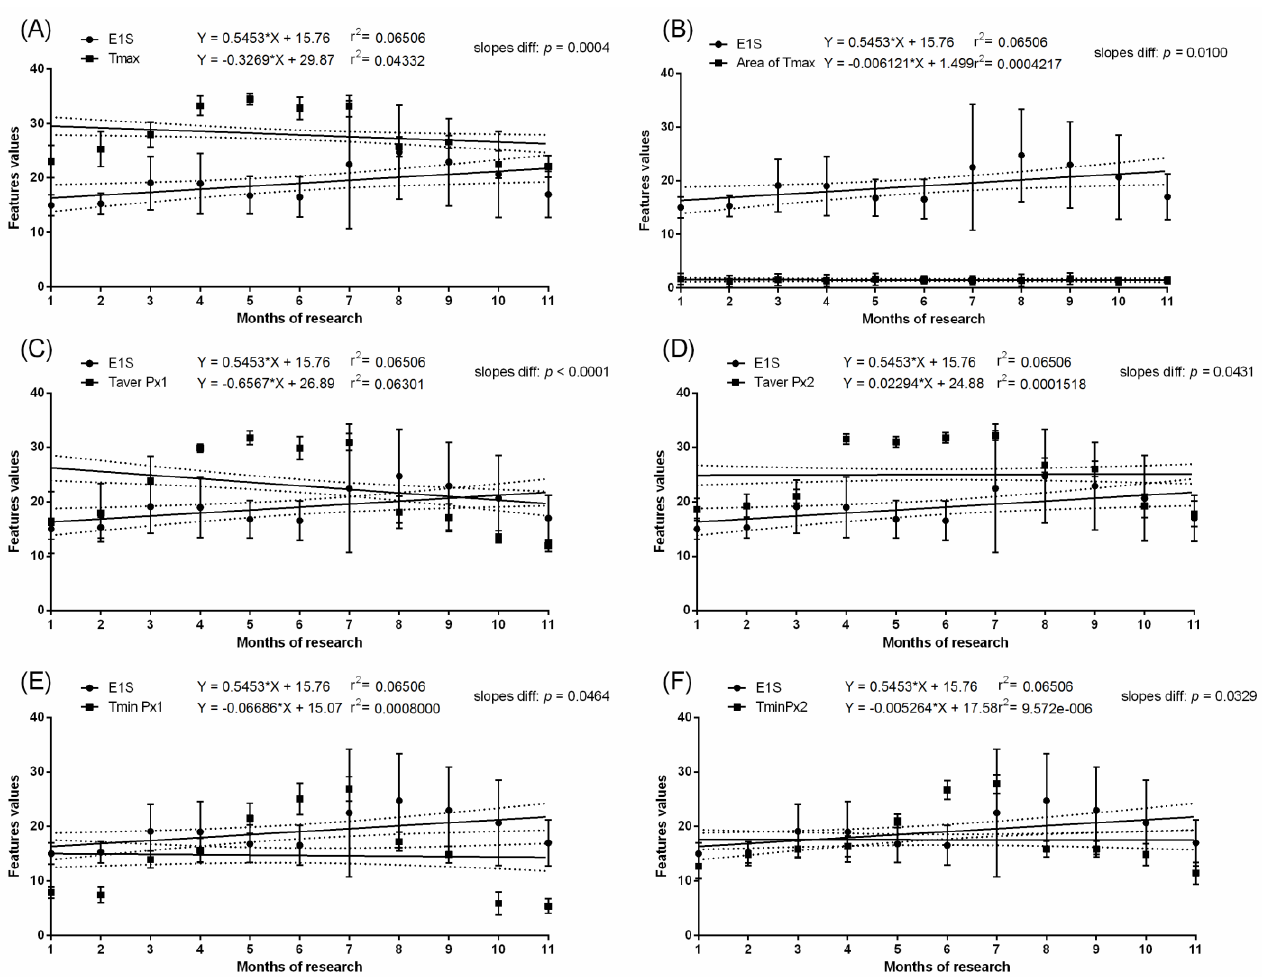
Figure 4. Linear regressions of estrone sulfate concentration in the serum and selected thermal features of the lateral surface of the abdomen in non-pregnant mares: the maximal temperature in Px1 and Px2 ( A ); the area with the highest temperatures in the range of 3 ◦ C ( B ); the average temperature in Px1 ( C ); the average temperature in Px2 ( D ); the minimal temperature in Px1 ( E ); the minimal temperature in Px2 ( F ).